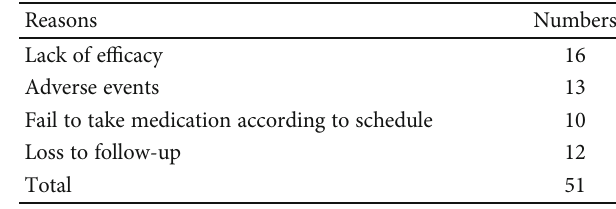
Table 2: The reasons for the dropout of 51 children during SLIT.